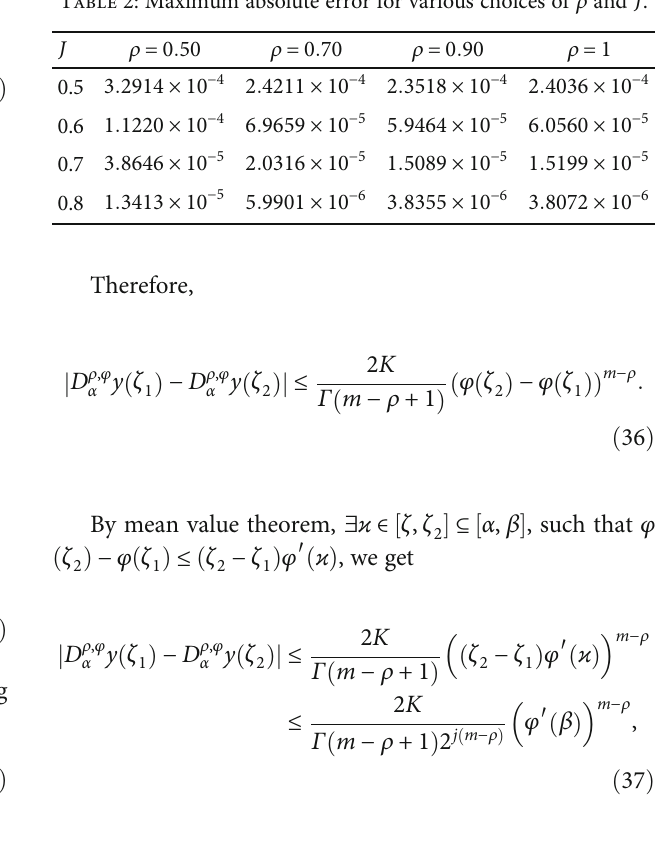
Table 2: Maximum absolute error for various choices of ρ and J